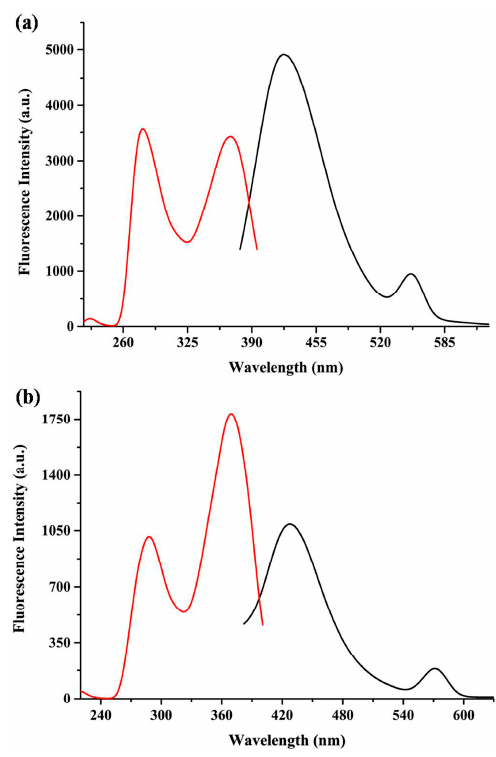
Figure 7. ( a ) The excitation and emission spectra of H 4 L; ( b ) The excitation and emission spectra of the Co(II) complex.